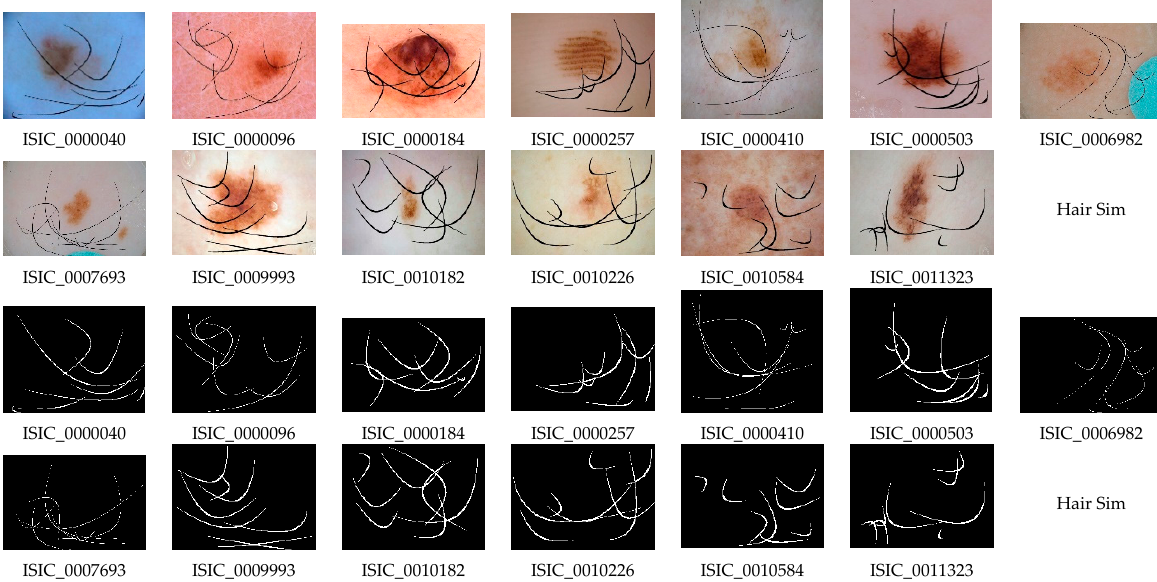
Figure 8. Image dataset sHSim-data with the hair mask produced by applying the HairSim method to sNH-data.